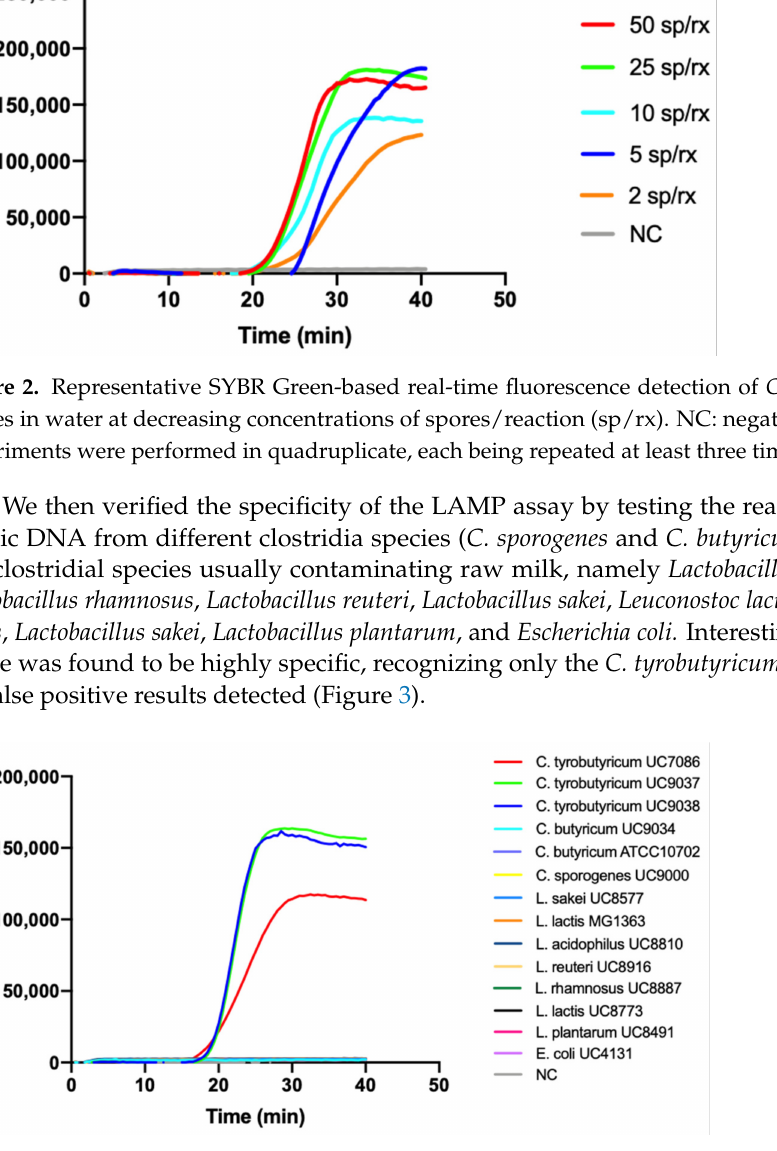
Figure 3. SYBR Green-based real-time fluorescent analysis of LAMP specificity based on genus- specific primer for C. tyrobutyricum . NC: negative